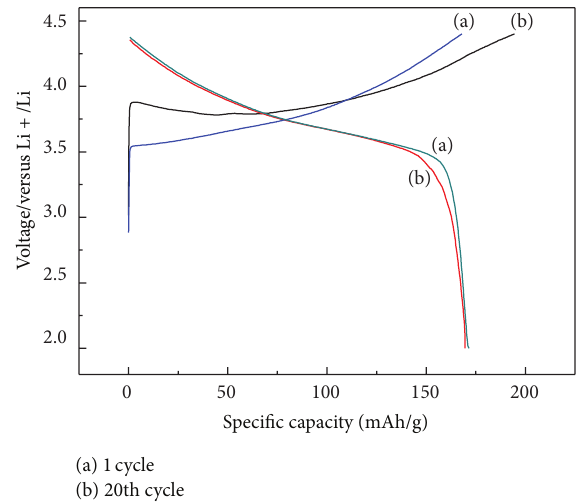
Figure 3: Initial charge-discharge curves of LiNi 0.7 ( 0 ≤ 𝑥 ≤ 0.1 ) at 0.1C in 2.0–4.4 V: (a) 𝑥 = 0.05 ; (b) 𝑥 = 0 ; (c) 𝑥 = 0.1 .